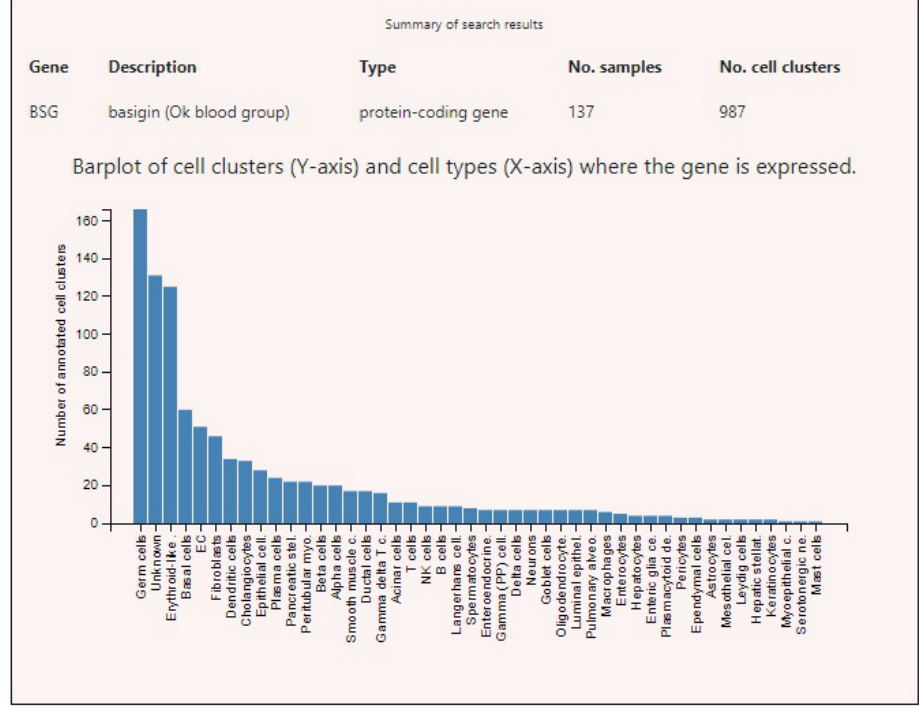
Figure 4. Basigin (BSG) expression levels in various human